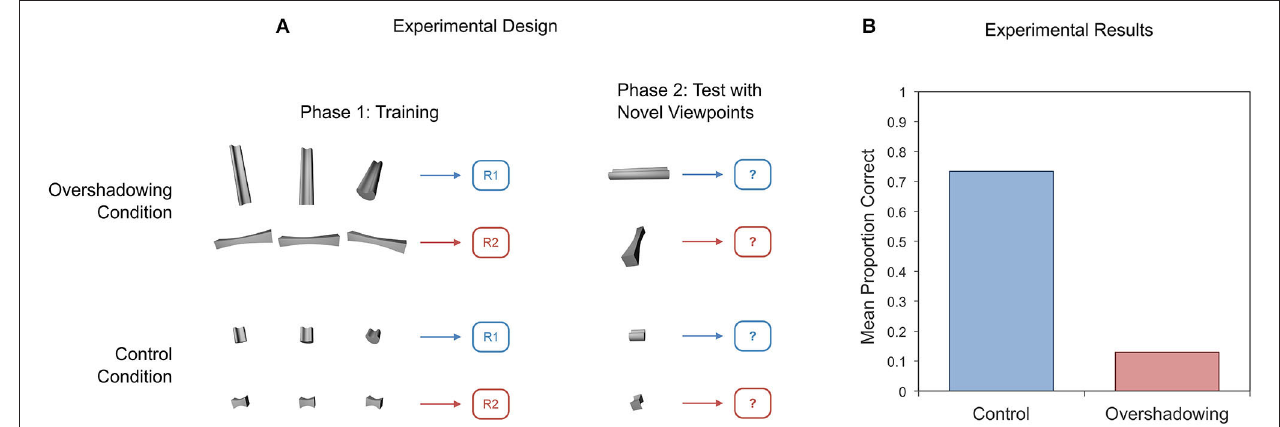
FIGURE 8 | Schematic diagram of an experiment on overshadowing of view-invariance learning (A) and results from an experiment with pigeons (B) . Bars in panel (B) represent responding to novel views of the training objects presented during Phase 2.